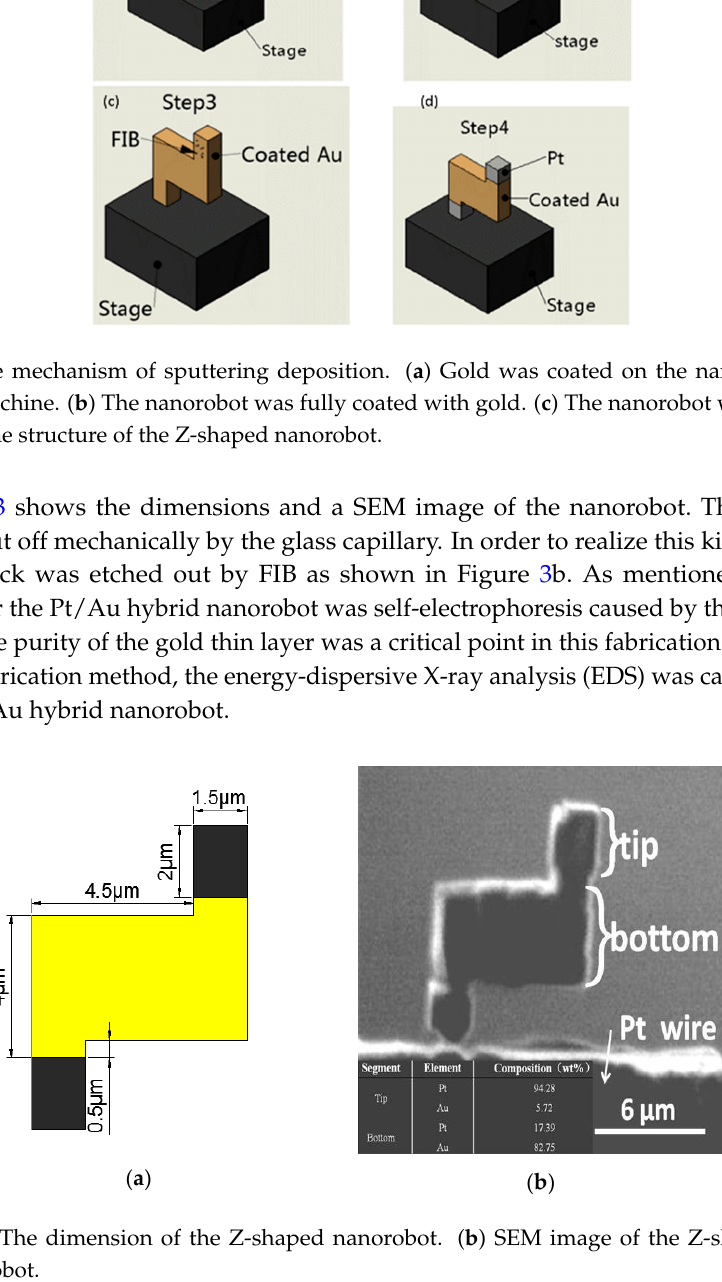
Figure 3. ( a ) The dimension of the Z-shaped nanorobot. ( b ) SEM image of the Z-shaped Au/Pt hybrid nanorobot.